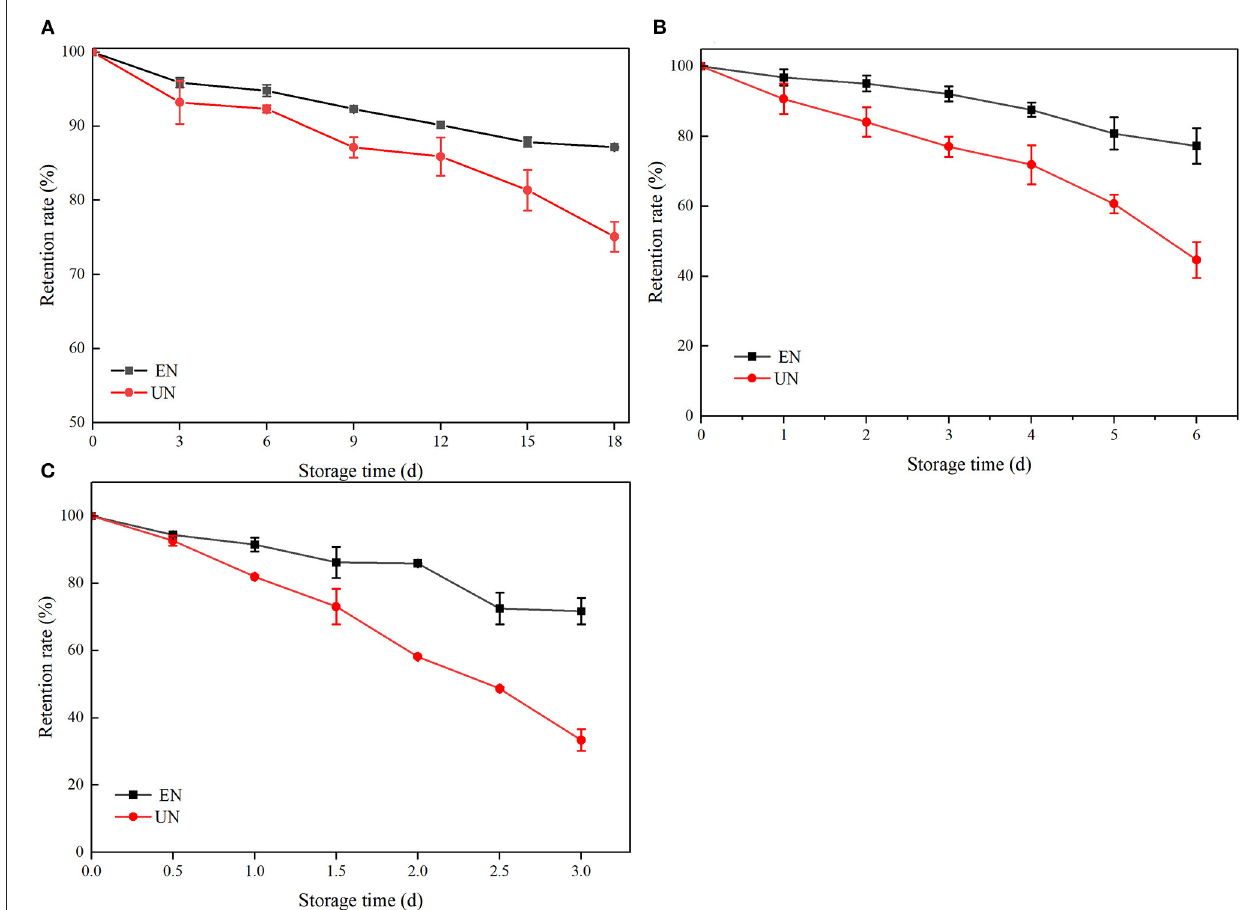
FIGURE 5 | The stability of black rice ATC at different temperatures [ (A) 4 ◦ C, (B) 25 ◦ C, and (C) 40 ◦ C].